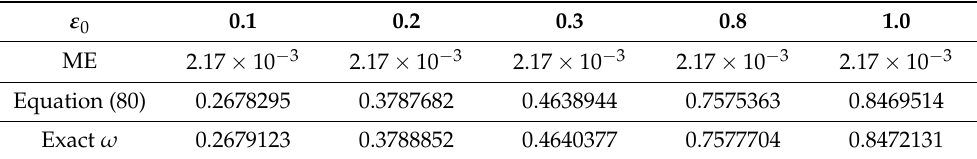
Table 4. The maximum errors (MEs) and frequencies for the analytic solution of Example 4 with different ε 0 .